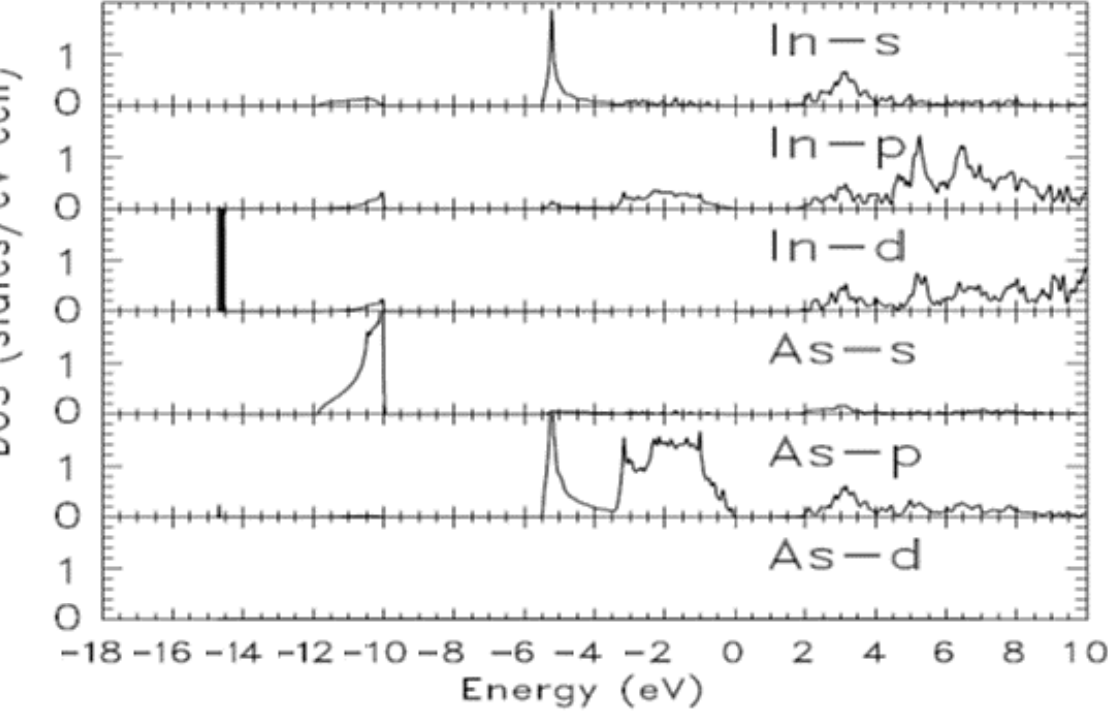
Figure 5. Calculated, partial densities of states (pDOS) for zb-InAs derived from the bands from Calculation IV. The zero on the horizontal axis indicates the position of the Fermi level.